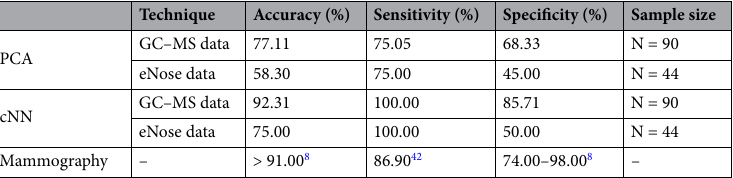
Table 3. Sample classification using biostatistics (PCA) and machine learning (cNN) vs reported performance of mammography.